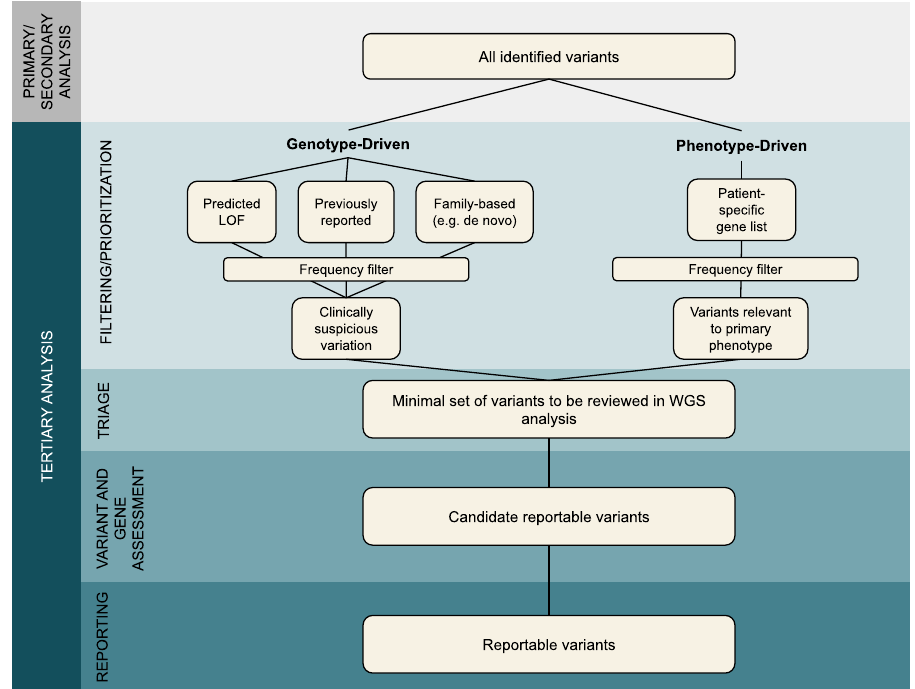
Fig. 2 WGS analysis process, including genotype-driven and phenotype-driven approaches. Minimum necessary data fi ltering and prioritization approaches are